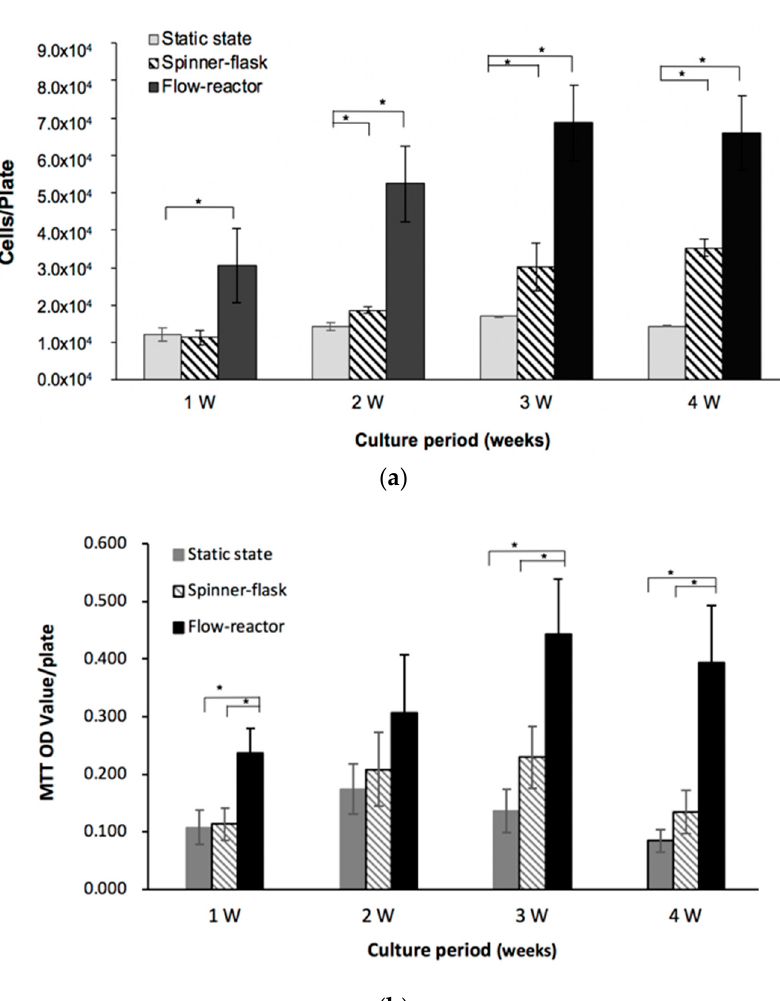
Figure 1. ( a ) The proliferation of human mesenchymal stem cells (hMSCs)with osteogenic medium under different culture environments was determined based on total DNA quantification , and the flow reactor had a large cell number relative to static-state culture and spinner flask ; ( b ) the mitochondria activity of hMSCs under variant culture system was determined by the 3-(4,5-Dimethylthiazol-2-yl)-2,5-diphenyltetrazolium bromide (MTT) assay, and cells in the flow reactor had a relatively higher viability (* p < 0.05). Table 1. The hMSCs’ expansion rate in di ff erent culture